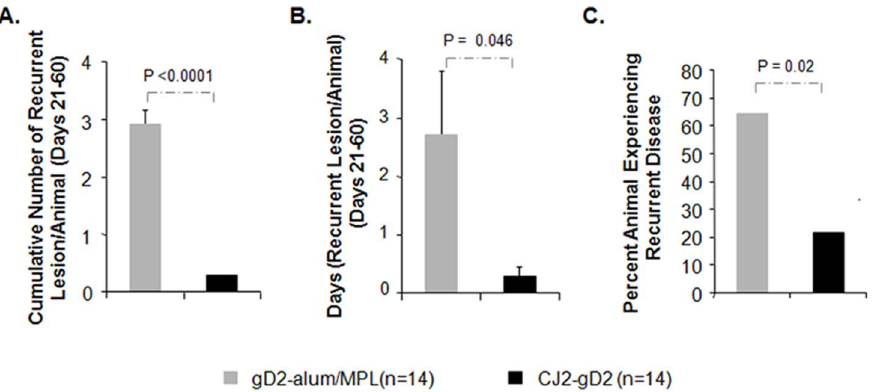
Figure 5. Prevention of recurrent HSV-2 disease in guinea pigs immunized with CJ2-gD2. After challenge with wild-type HSV-2, individual guinea pigs described in the legend of Fig. 4 were monitored daily during a 60-day follow-up period for the incidence of genital and disseminated HSV-2 disease. Presented are the cumulative numbers of recurrent lesions per animal (A), number of days that recurrent disease was experienced per animal (B), and the percent of animals that experienced recurrent disease between days 21 to 60 after challenge (C).